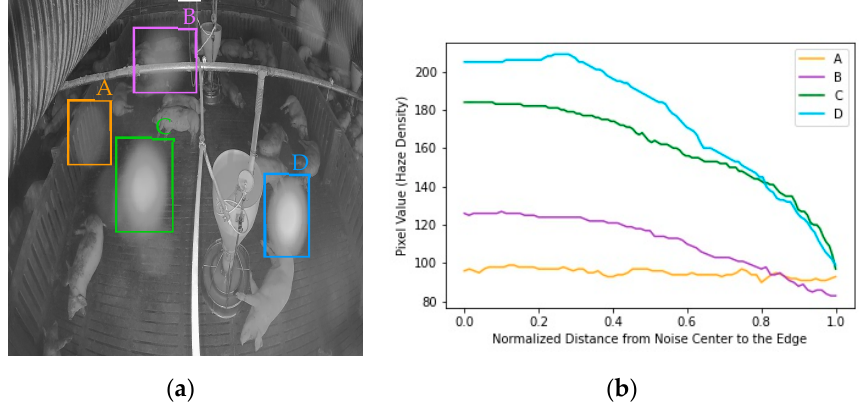
Figure 7. Noise level and variations: ( a ) Four noises appear on the pigpen; ( b ) Noise level and variation from the center to edge of each noise.